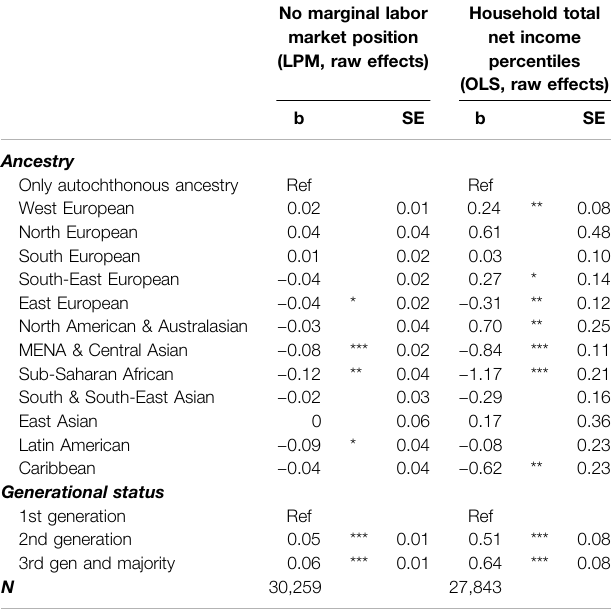
TABLE 5 | Regression models for structural integration (linear main effects models).